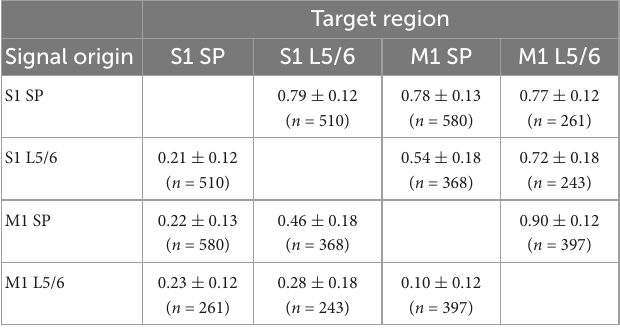
TABLE 6 Directionality of connections between by S1Bf–M1 silicon probe